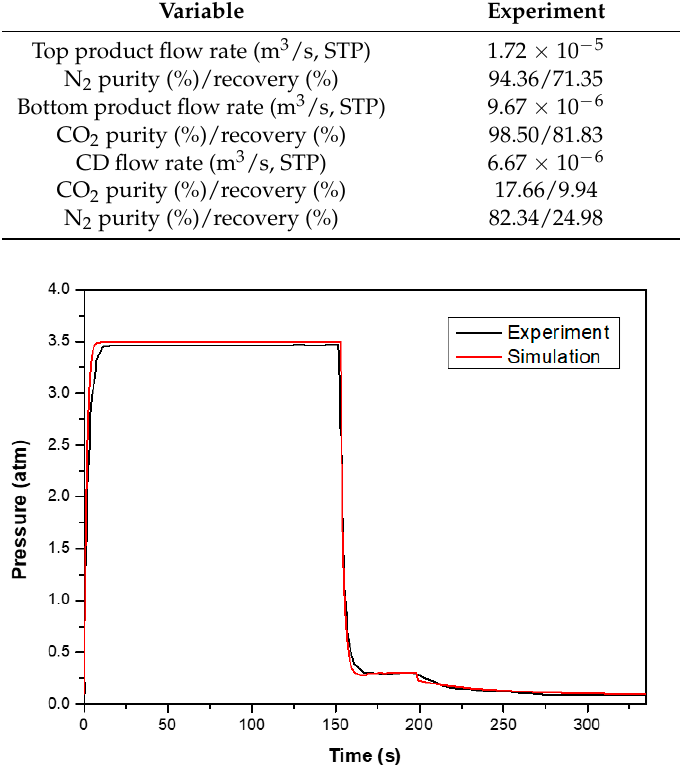
Figure 9. Pressure profile of the single-bed three-step PSA experiment and simulation.